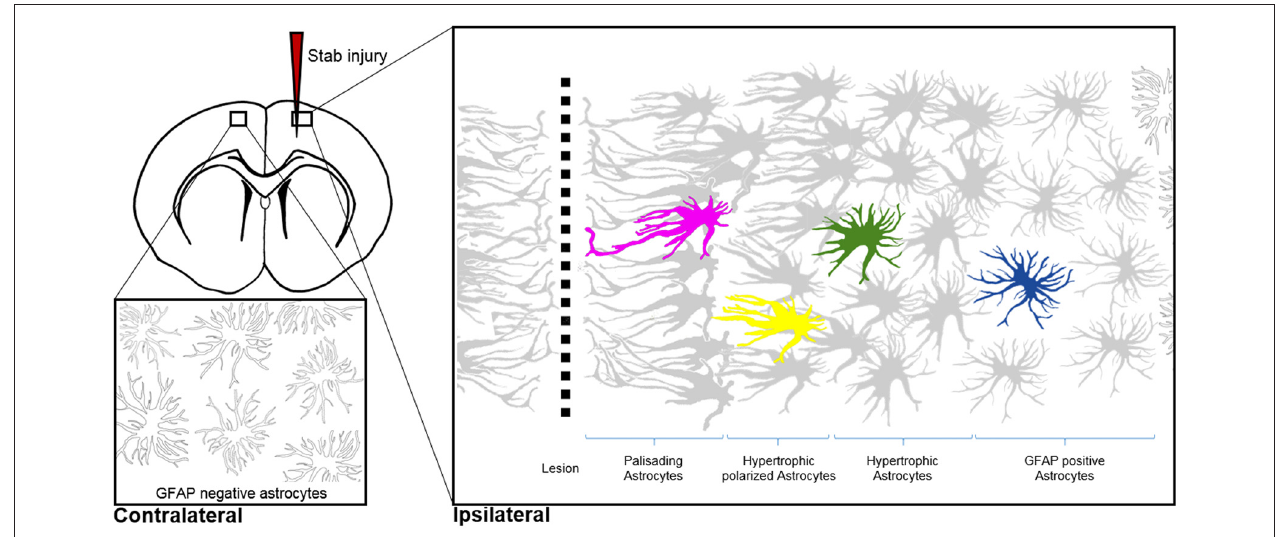
FIGURE 3 | Morphological hallmarks of reactive astrocytes in traumatic brain injury. Typical distribution of reactive astrocytes after a cortical stab wound in the mouse cortex 7 days after injury. Schematic drawings show the main processes of astrocytes, which contain high levels of GFAP (gray) upon injury. GFAP-positive astrocytes exhibit different morphologies depending on their distance from the lesion site: in the immediate vicinity (magenta), astrocytes polarize and extend long “palisading” processes. In the second row, multiple processes of the hypertrophic astrocytes (yellow) are orientated towards the injury site; with increased distance, astrocytes possess hypertrophic cell bodies and primarily main processes (green). Finally, reactive astrocytes at the border of the unaffected parenchyma upregulate GFAP but show no signs of hypertrophy (blue). Note that cortical astrocytes in the uninjured contralateral hemisphere sparsely express GFAP, as indicated with silhouettes (bottom left